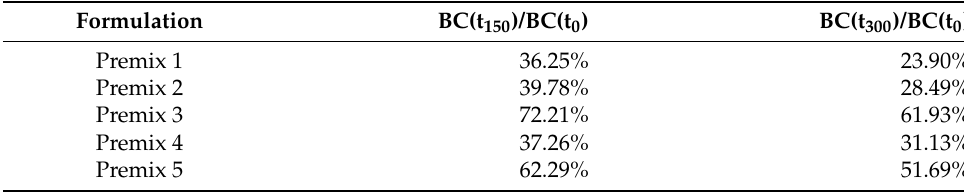
Table 3. Relative decrease in bubble count over